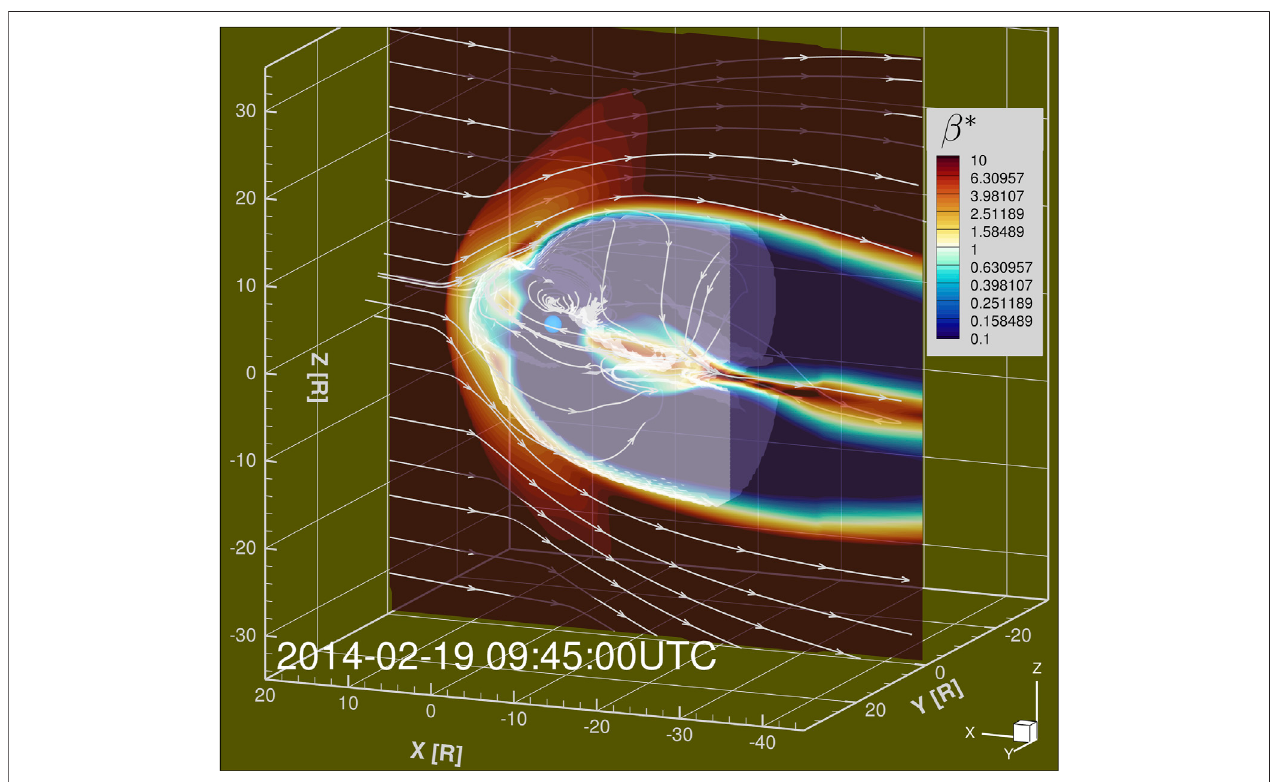
FIGURE 6 | 3D snapshot of total energy transfer vector K fl ow fi eld with meridional cut showing color contours of β *. Translucent structure represents identi fi ed magnetopause surface out to − 20 R e in the x